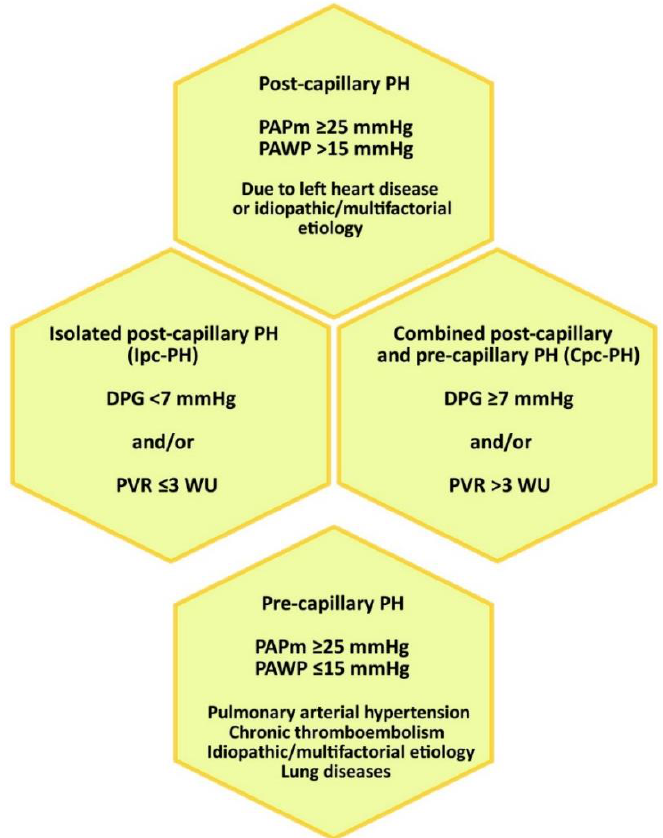
Figure 3. The clinical characteristics of pulmonary hypertension on the base of current guidelines. PH—pulmonary hypertension, PAPm—pulmonary artery pressure mean, PAWP—pulmonary artery wedge pressure, DPG—diastolic pressure gradient, PVR—pulmonary vascular resistance.